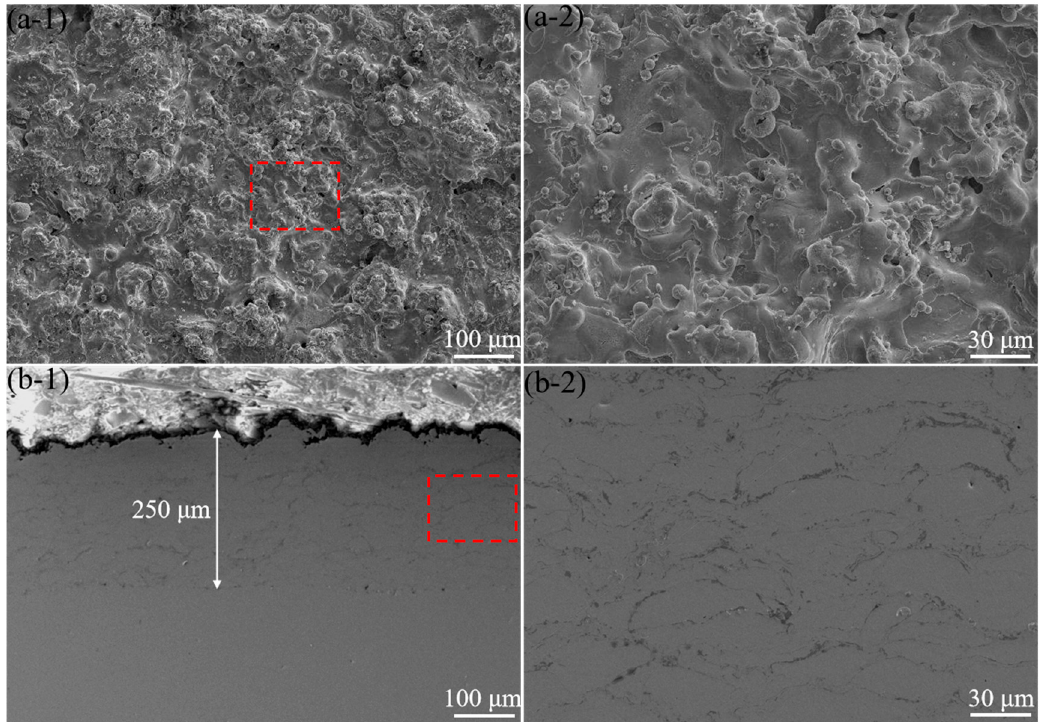
Figure 1. Surface ( a-1 , a-2 ) and cross-sectional ( b-1 , b-2 ) microstructures of the as-sprayed 316L stainless steel coating. stainless steel